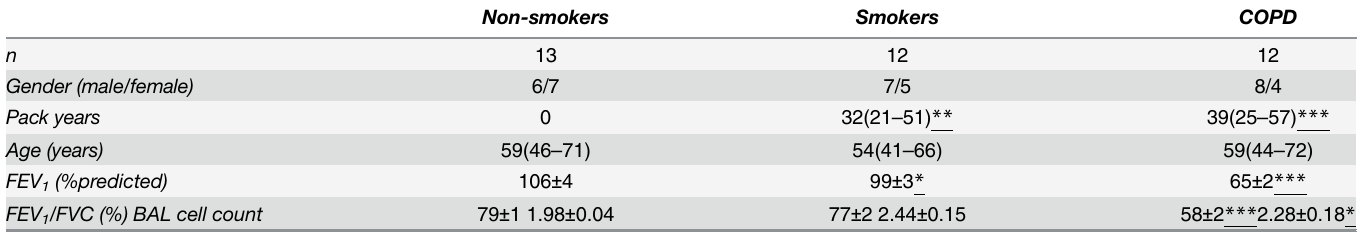
Table 1. Sputum and BAL participant details. FEV 1 : Forced expiratory volume in one second; FVC: forced vital